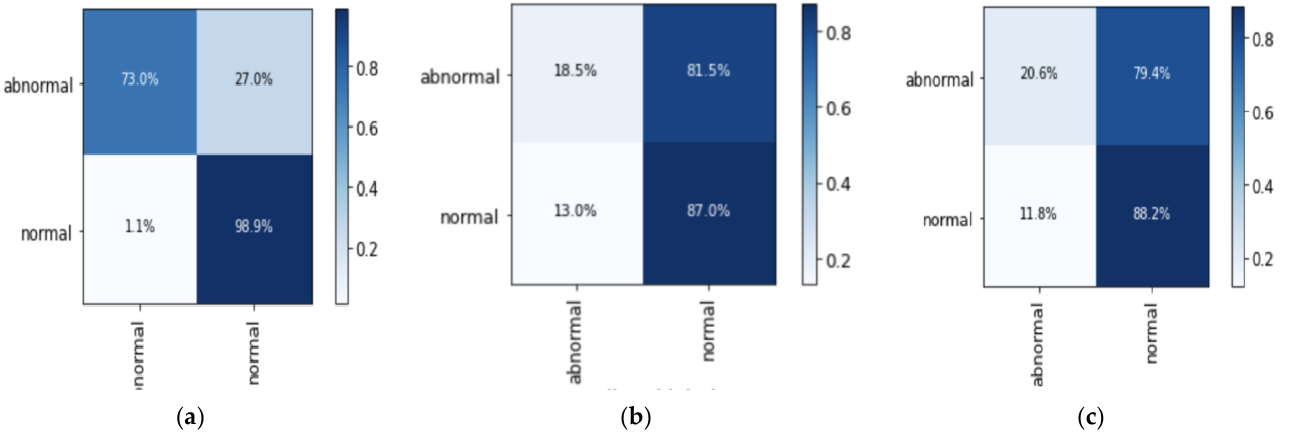
Figure 3. The confusion matrix by three different algorithms. ( a ) UMAP-RF algorithm. ( b ) LOF algorithm. ( c ) Isolation Forest algorithm.